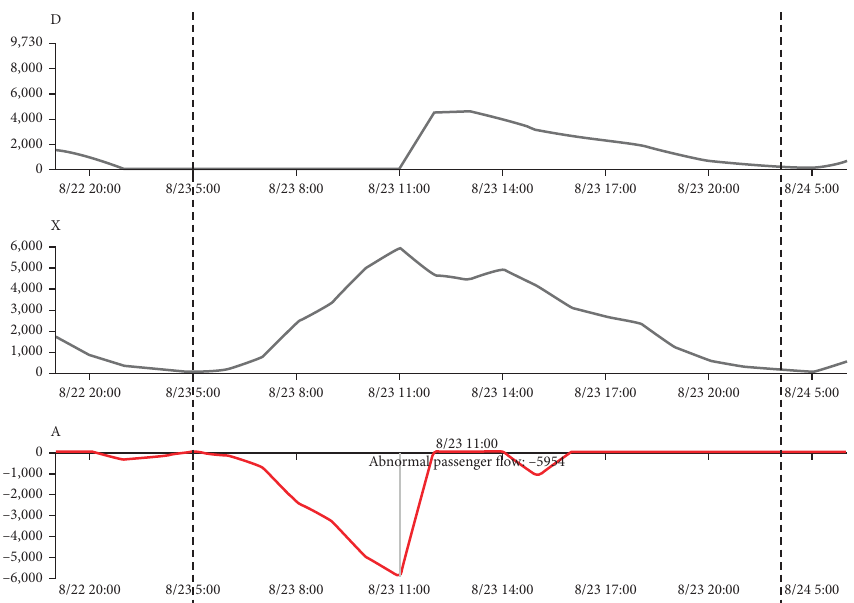
Figure 6: The detection results of passenger flow for Xidan station on August 23.